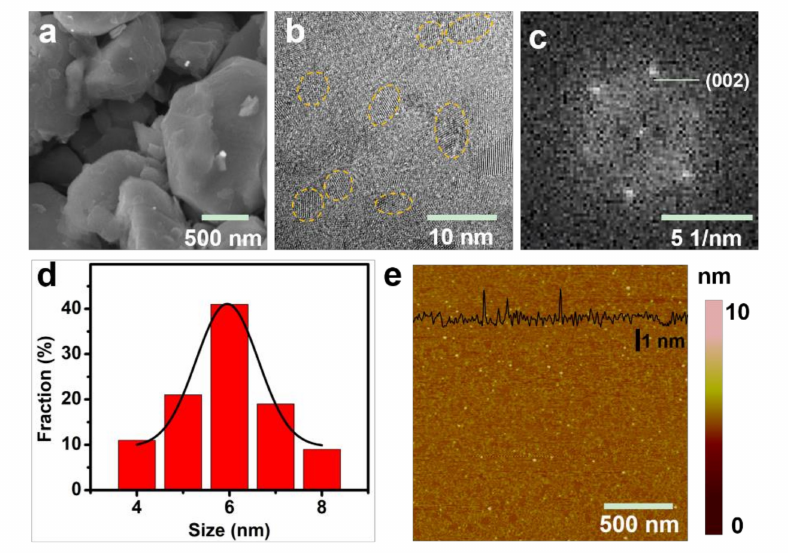
Figure 2. ( a ) SEM image; ( b ) TEM image of Mo 2 C QDs and ( c ) the corresponding fast Fourier transform (FFT) patterns of ( b ); ( d ) The diameter distribution analysis of Mo 2 C QDs; ( e ) Atomic force